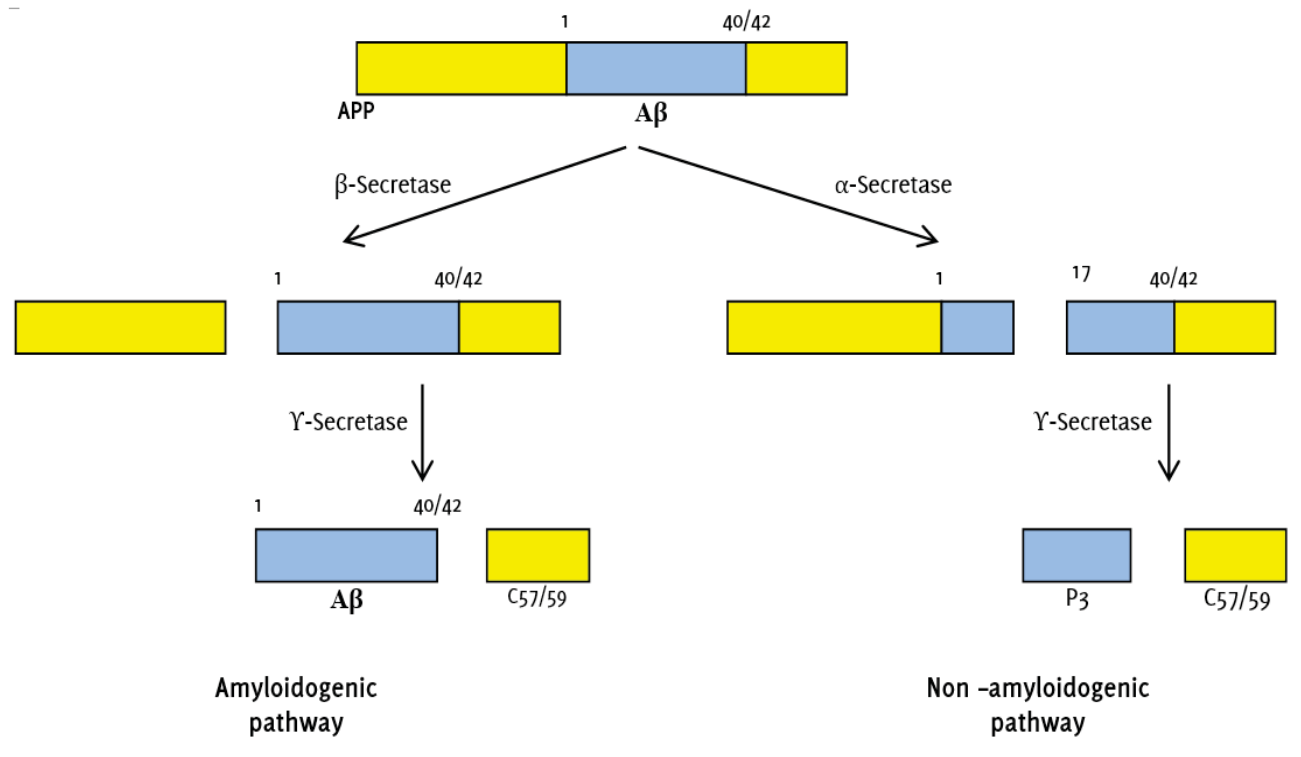
Figure 1. The Amyloid Hypothesis: Amyloidogenic and Non-amyloidogenic